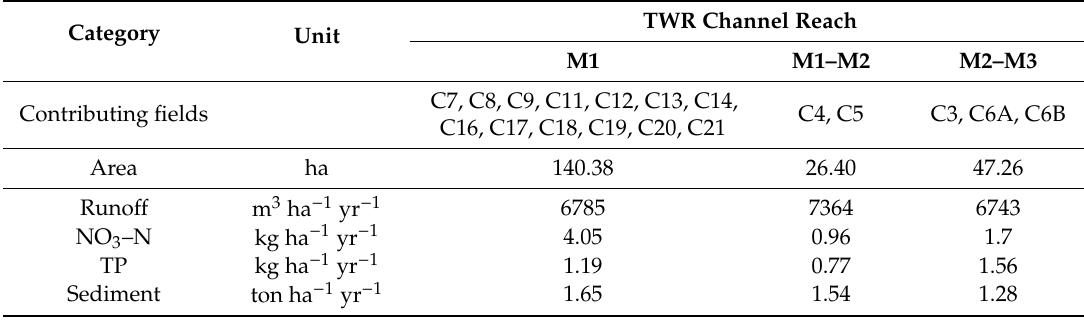
Table 4. Contributing fields to each channel reach, production of average annual runo ff and load of nutrients and sediments entering the TWR